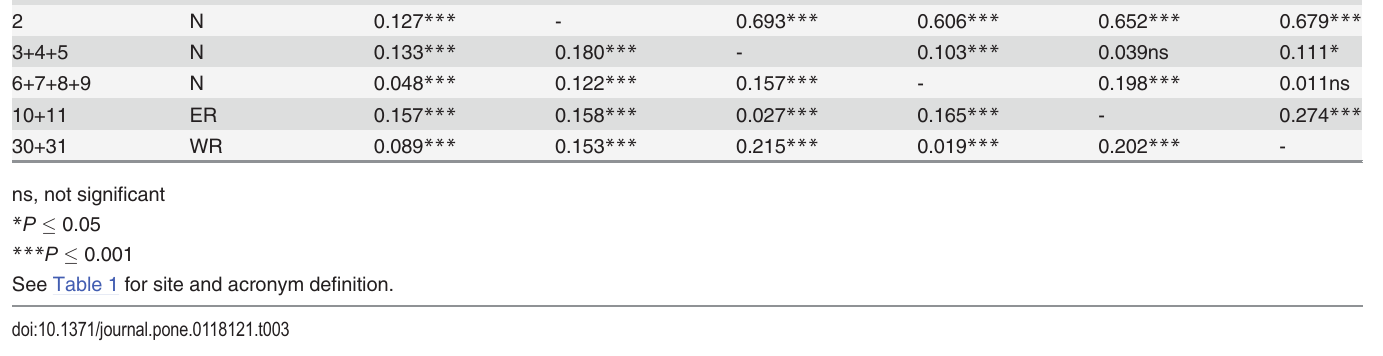
Table 3. Genetic pairwise differentiation for Dikerogammarus villosus estimated for microsatellites ( F ST , below diagonal) or mitochondrial DNA ( Θ ST , above the diagonal) between sites or group of sites in the native area and invasion fronts in Poland.